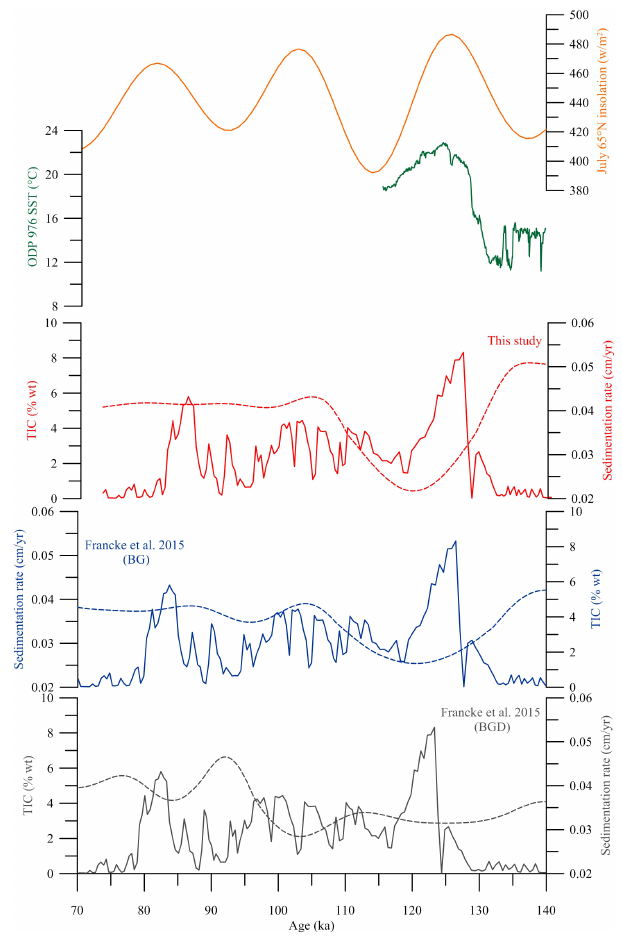
Figure 4. From bottom: TIC (%wt) and sedimentation rate of DEEP site plotted on age models from Francke et al. (2015, Dis- cussion version, grey); Francke et al. (2016, blue); this study (red); Alkenone SST ( ◦ C) for core ODP-976 (Marino et al., 2015, green); Summer (July) insolation at 65 ◦ N (orange; Berger and Loutre,